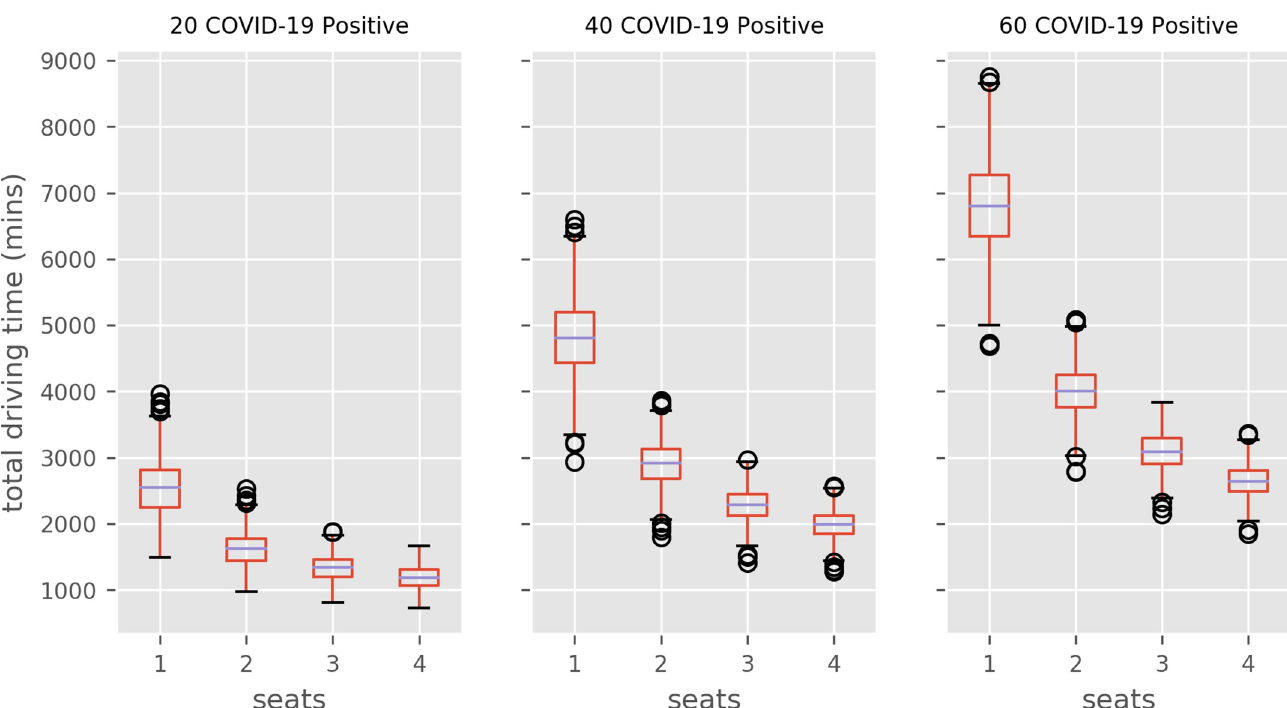
Fig 6. Two-way ambulance transport time distributions (1000 model runs). Results compare population COVID-positive and ambulance seating capacity (e.g. 2 = 2 seats.) Figures do not include ambulance clean-down/turnaround time.